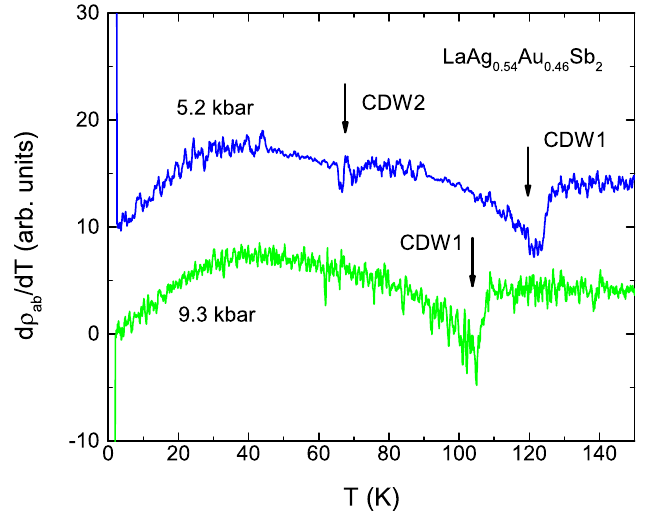
Figure A1. Resistivity derivatives, d ρ ab / dT , data at 5.2 kbar and 9.3 kbar for LaAg 0.54 Au 0.46 Sb 2 . Arrows point to CDW transition temperatures. The 5.5 kbar data are shifted vertically by 10 for